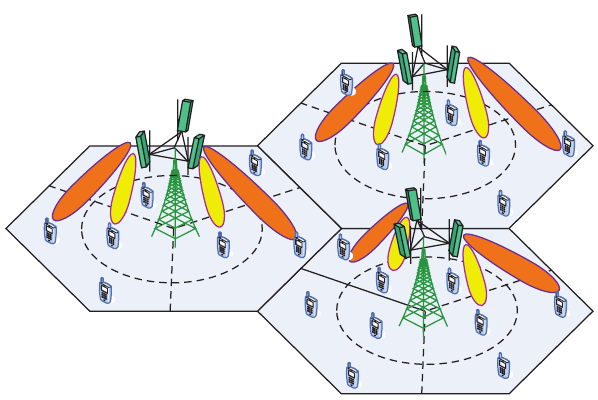
Figure 1: vertical sectorization and 3 × 2 sector